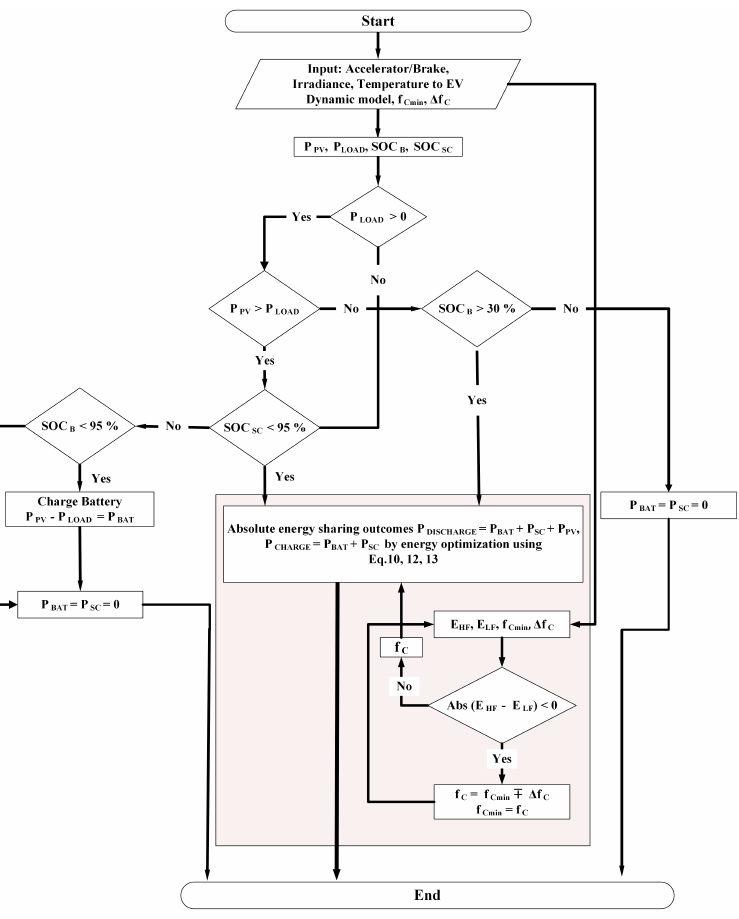
Figure 8. Flowchart of absolute energy-sharing